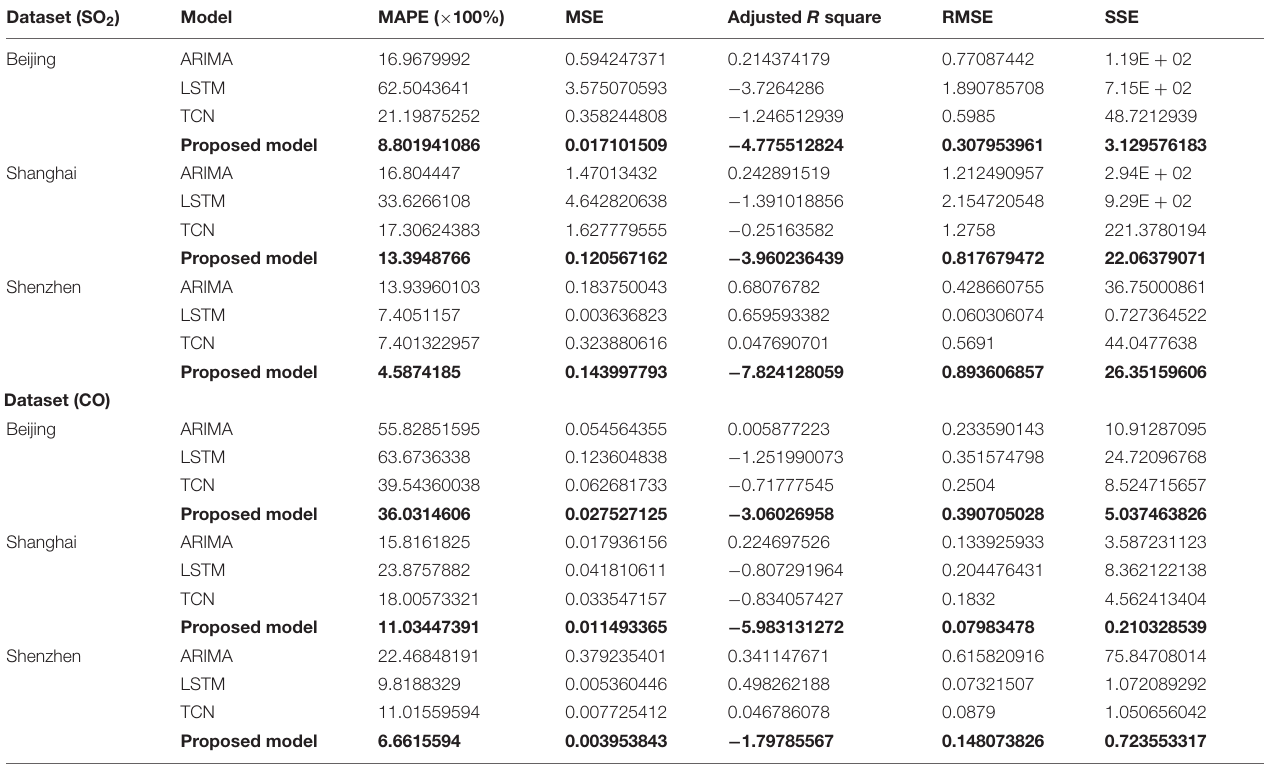
TABLE 7 | The forecasting performances of various models for SO 2 and CO in three cities. Dataset (SO 2